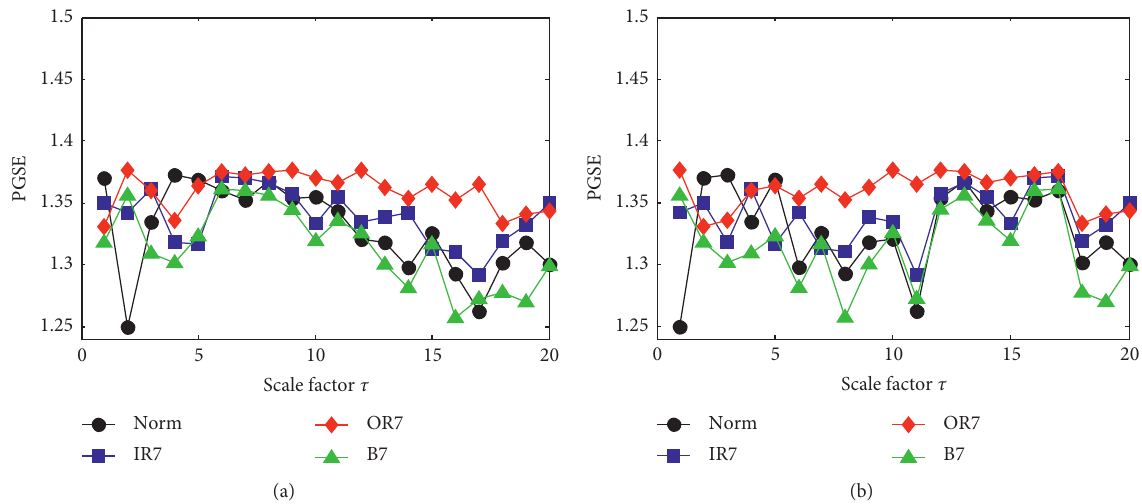
Figure 18: (a) The original distribution of MPGSE and (b) the new distribution of MPGSE after applying the LS method in case 1.